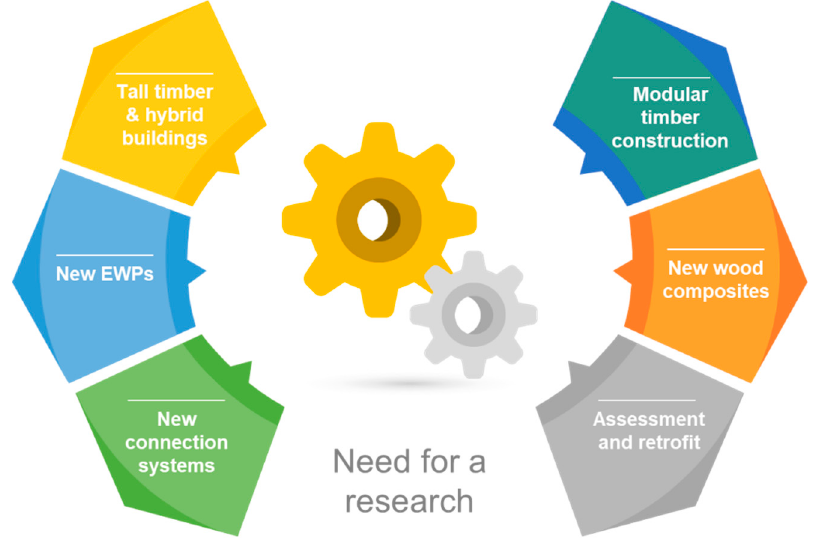
Figure 1. Future need for a research in timber engineering.